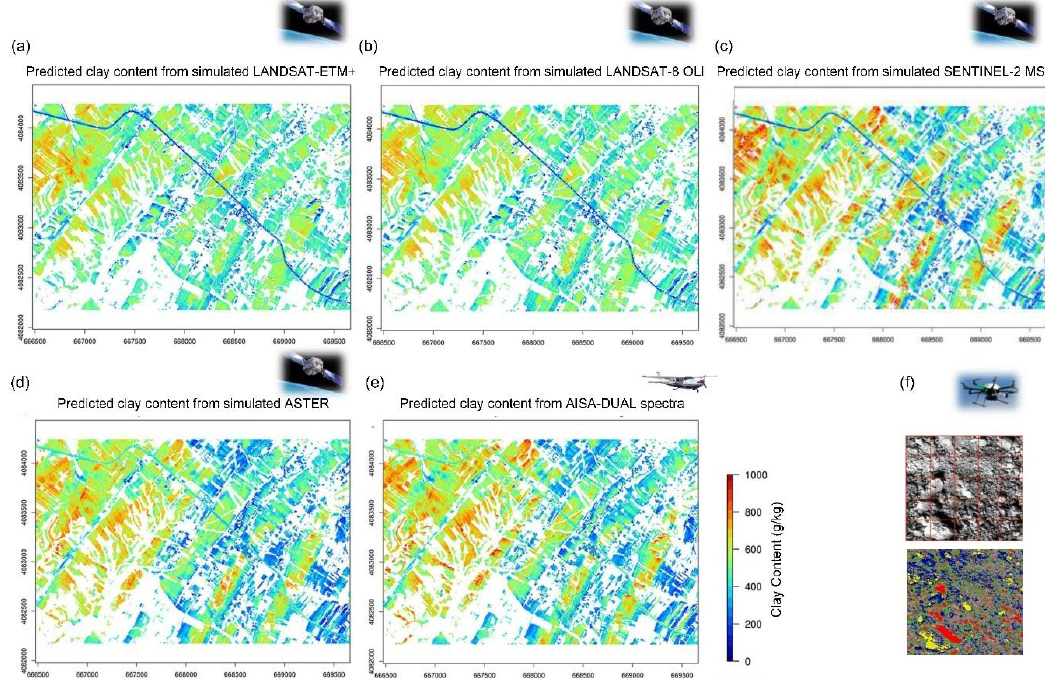
Figure 5. Maps of clay content over the Kamech catchment predicted from the PLSR (partial least squares regression) models using spectral configurations from ( a ) LANDSAT-7 ETM + , ( b ) LANDSAT-8 OLI, ( c ) SENTINEL-2 MSI, ( d ) ASTER, ( e ) AISA-DUAL (from Gomez et al. [68], License Number 4582290225360; ( f ) soil texture and soil microstructures derived from hyperspectral video camera–Cubert (from Jung et al. [136]).